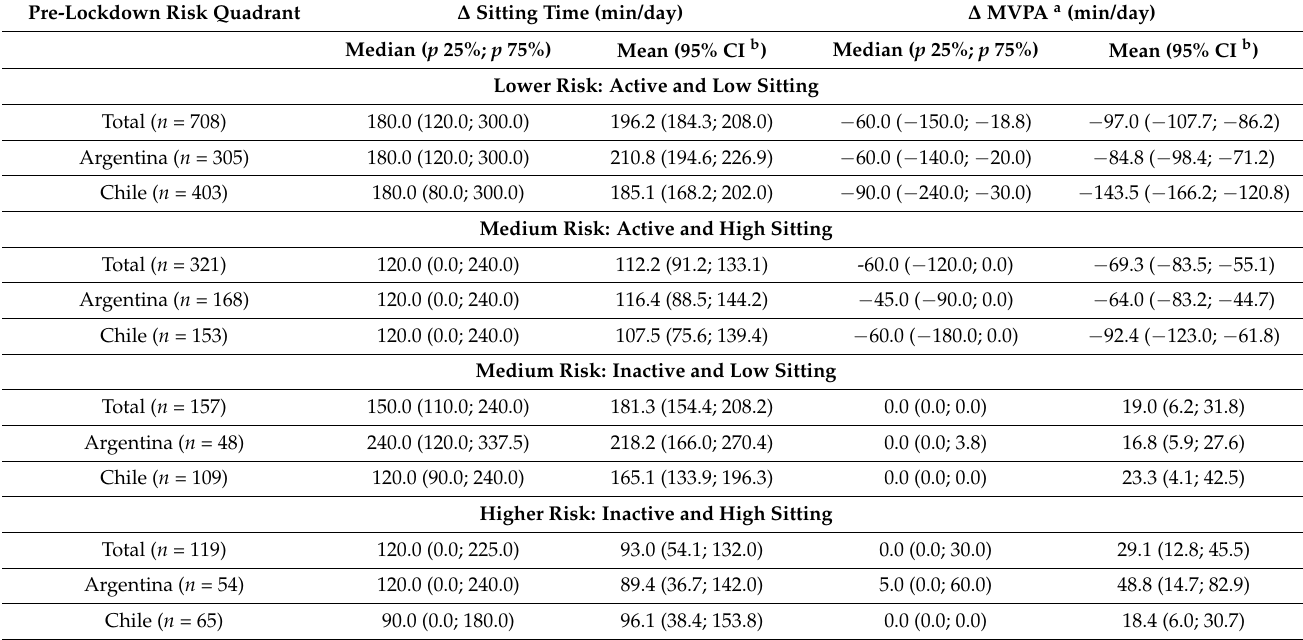
Figure 1. Risk quadrants according to physical activity recommendations and sitting time. Table 3. Changes in sitting time and moderate to vigorous physical activity according to pre-lockdown risk